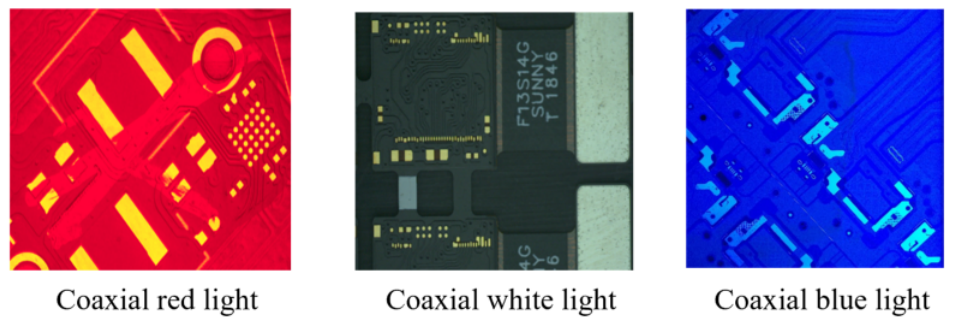
Figure 2. Comparison of the collection effect of different colors of light under the coaxial light